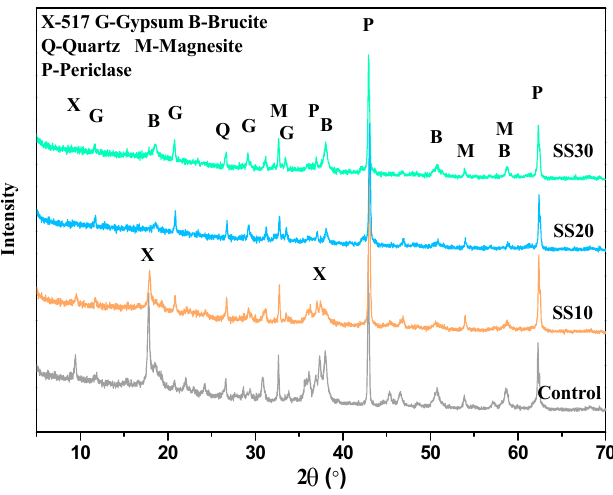
Figure 6. Powder XRD patterns of the control, SS10, SS20, and SS30 with CO 2 treatment at 28 days.